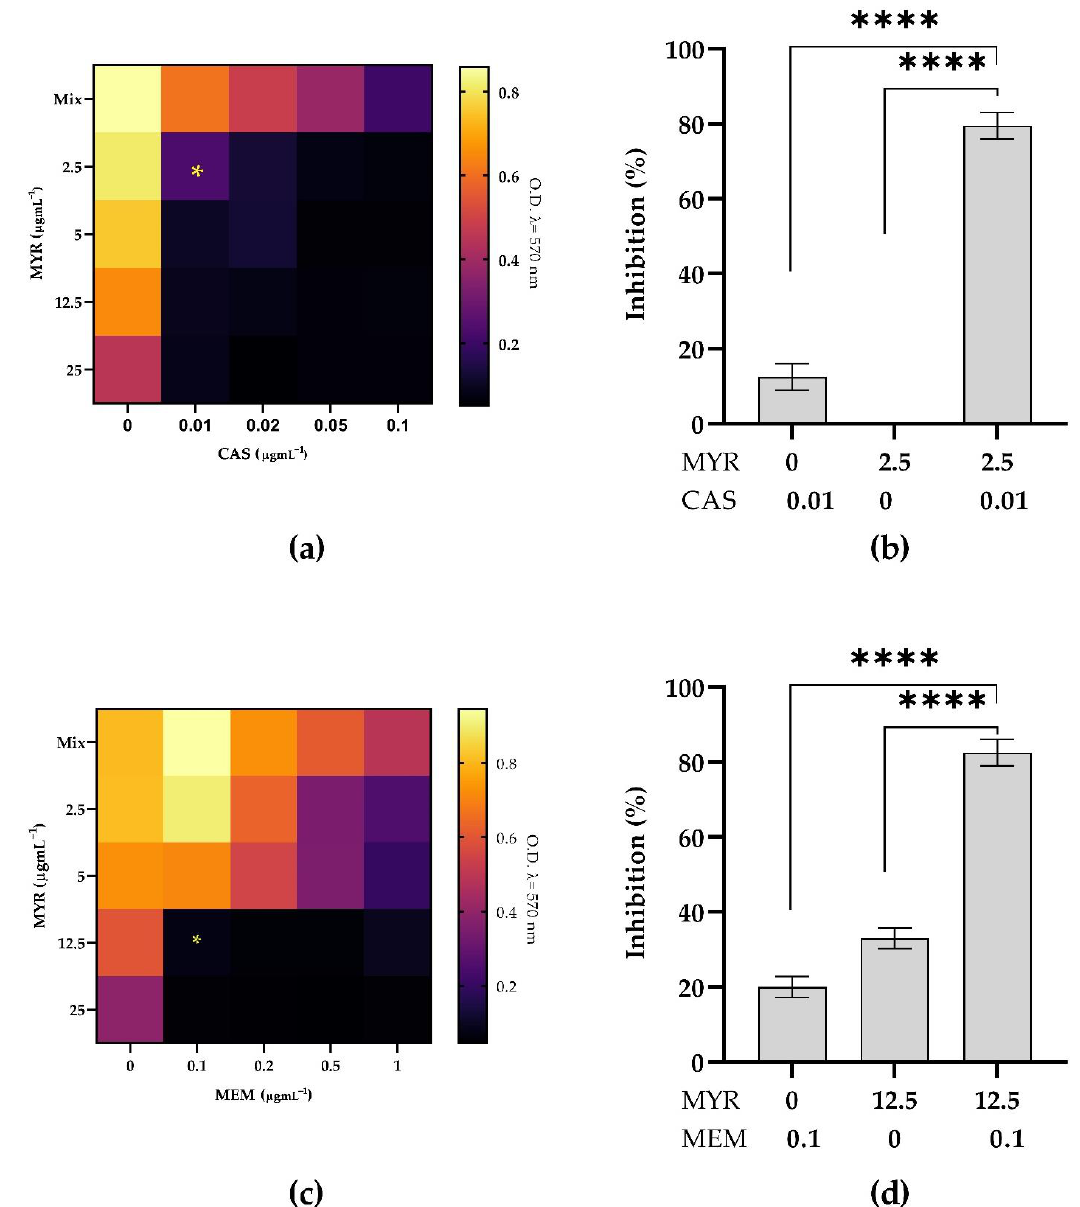
Figure 6. Combined activity of MYR with CAS ( a , b ) and MEM ( c , d ) against dual-species biofilm of C. auris and K. pneumoniae ; panels ( a , c ) show checkerboard assay, and panels ( b , d ) show percentage of inhibition of biofilm formation. Stars indicated indicate synergy (FICI ≤ 0.5); **** = p < 0.0001 (Dunnett’s